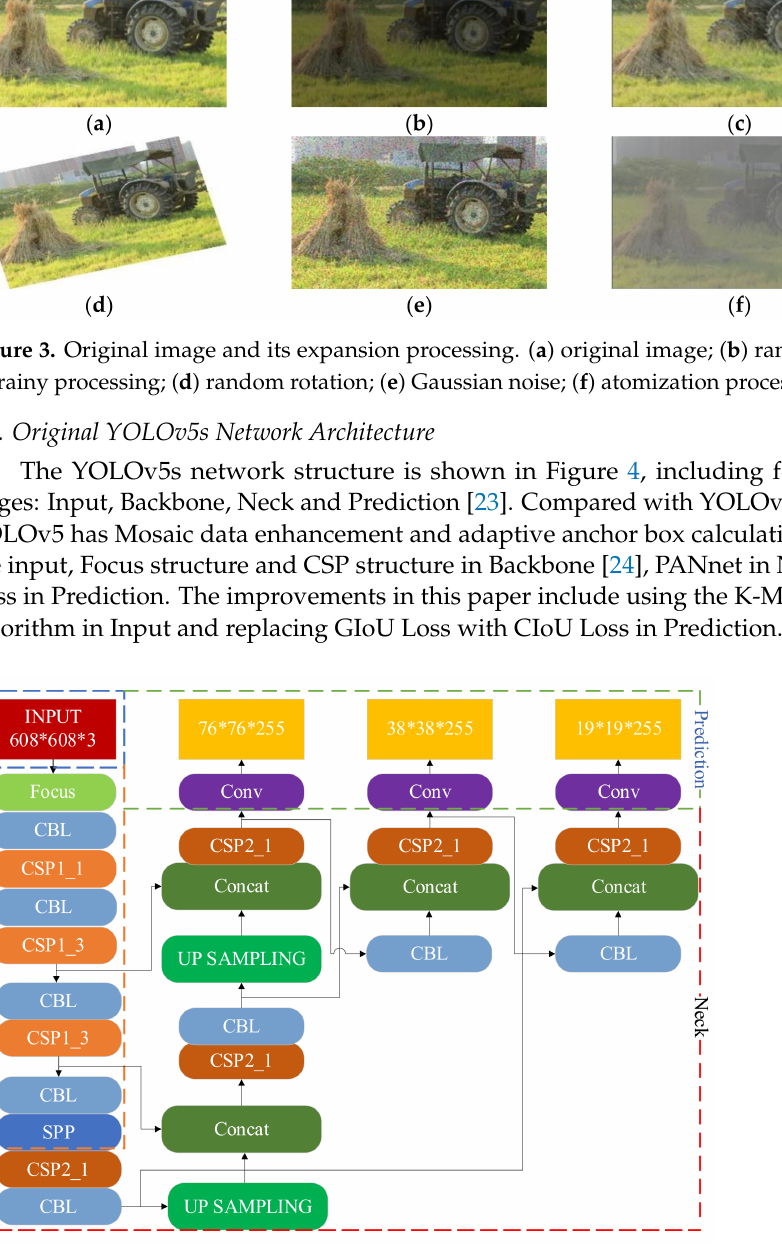
Figure 4. Network structure of the original